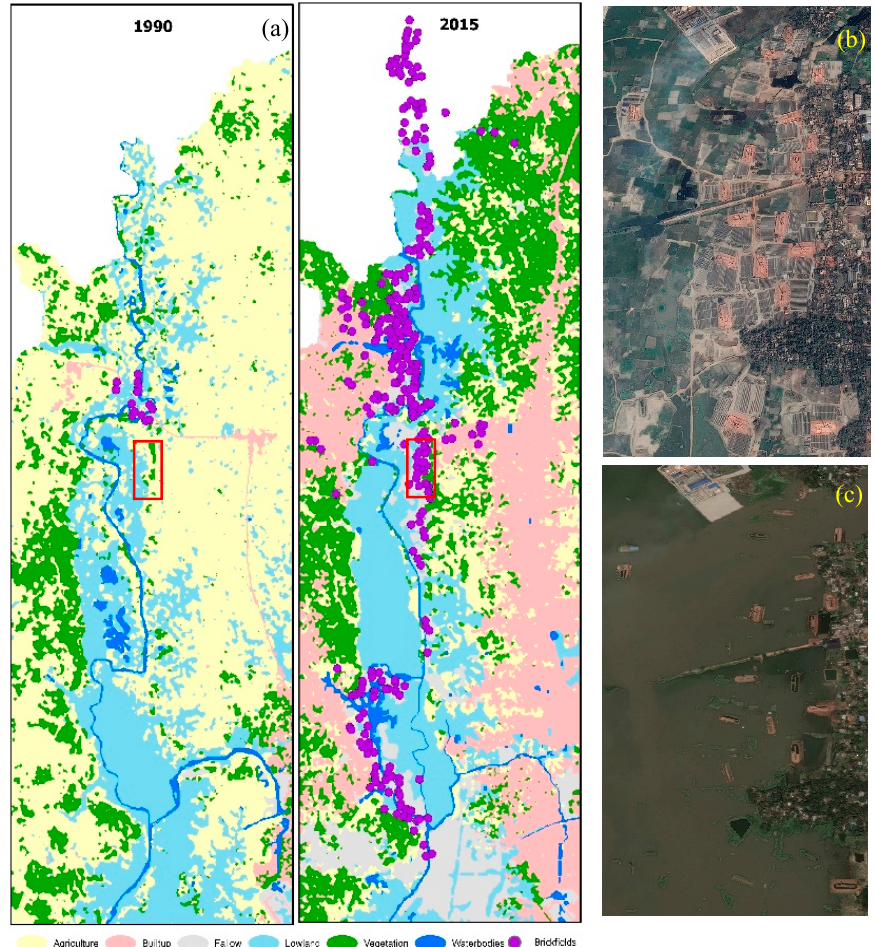
Figure 9. Subset of land cover map in the north-west of greater Dhaka between 1990 and 2015. ( a ) A substantial expansion of brickfield in wetland and across river channel during the study period. ( b ) Cluster of brickfields (location is highlighted in red color on landcover map) in the wetland of Basan in Gazipur, north of Dhaka metropolitan area, shown on a Google Earth image during the dry season (January 20, 2018). ( c ) The same area during the wet season (June to October) inundated by monsoon.